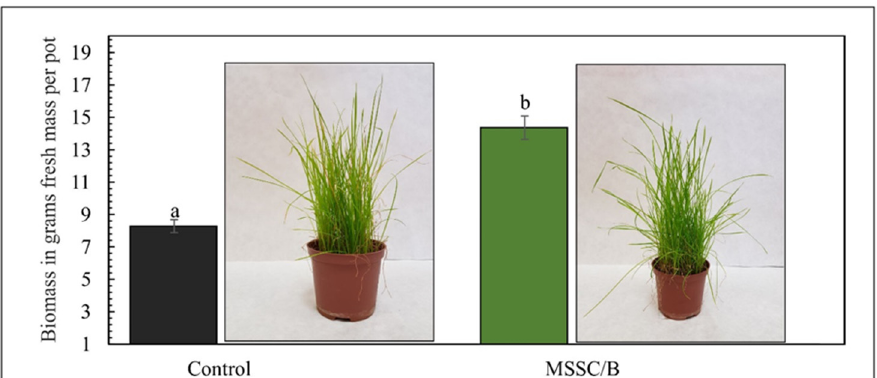
Figure 1. Effect of MSSC/B on D. glomerata growth in PTE-contaminated soil. Mean ± SD with different lowercase letters indicate significant differences among treatments ( p < 0.05), analyzed using one-way ANOVA.